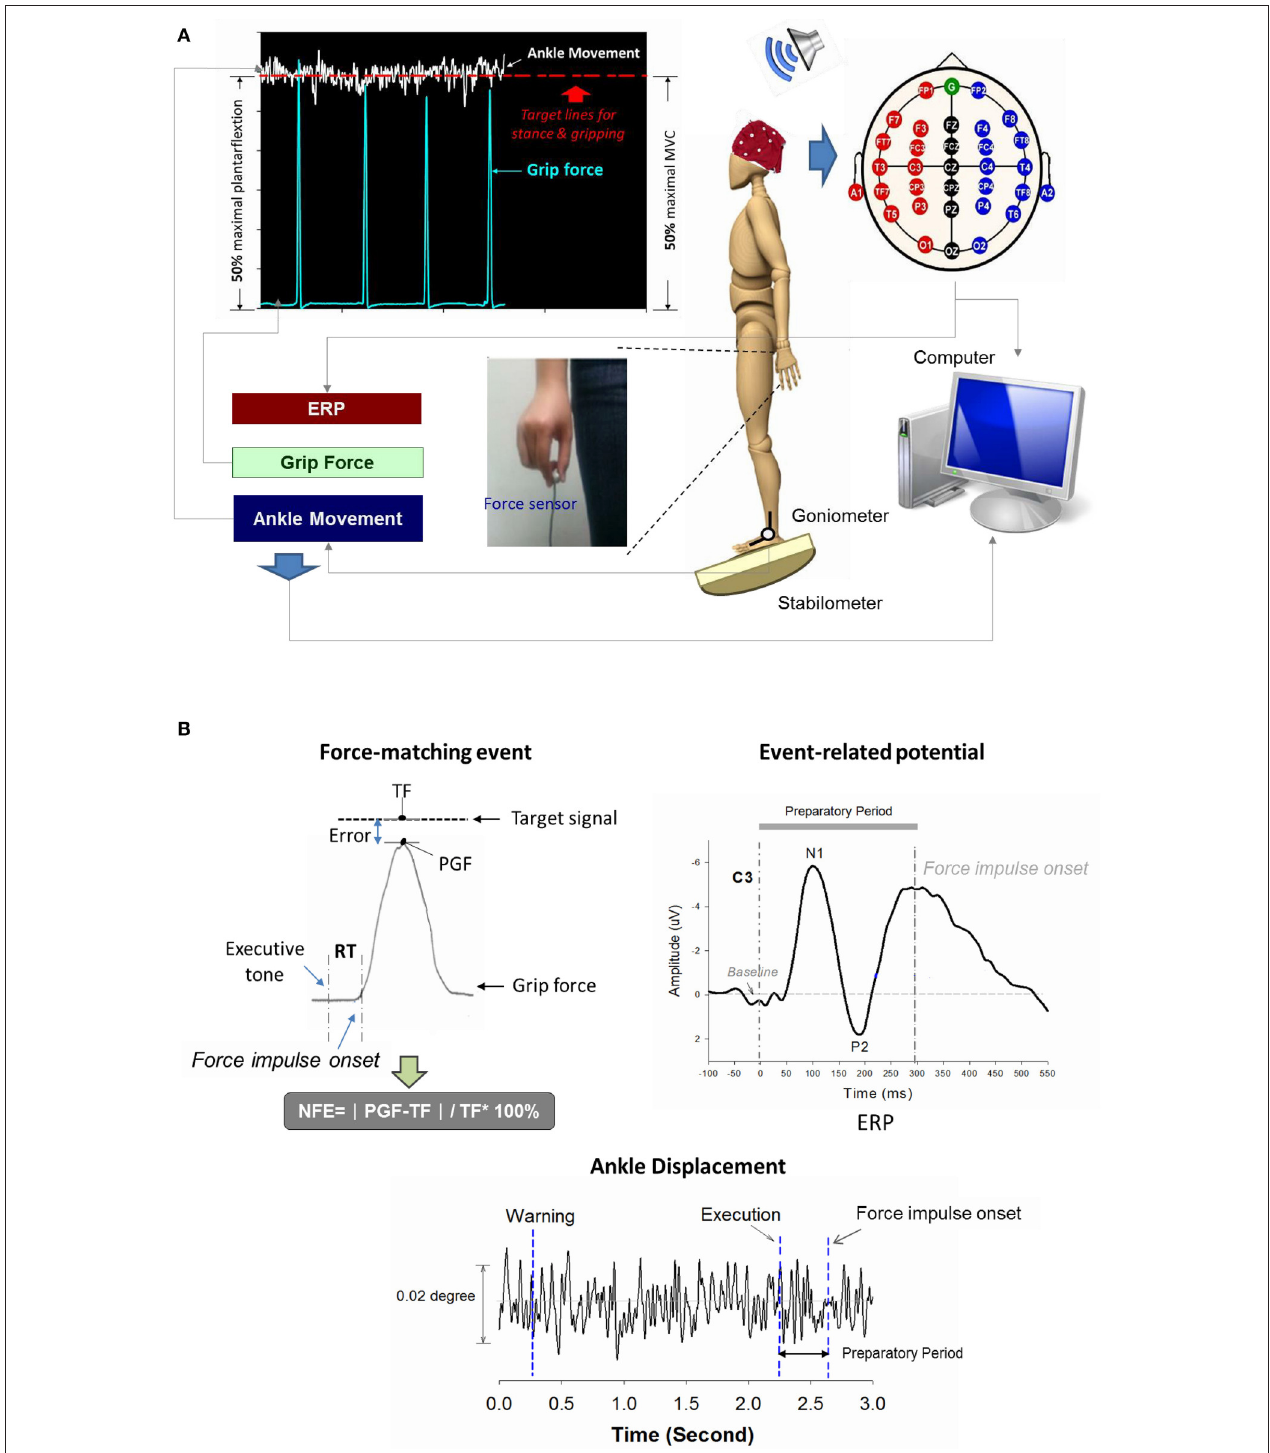
FIGURE 1 | Schematic illustration of experimental setup (A) and physiological data (B). Real-time display of precision grip force, ankle displacement, and target signals for concurrent force-matching and postural tasks. By separate scale-tuning of the manual force target and postural target, the target signals of both postural and force-matching tasks could be displayed in an identical position on the monitor. Suprapostural performance was assessed with the reaction time (RT) and normalized force error (NFE) of a force-matching act. The event-related potential (ERP) of the force-matching act was recorded with scalp electroencephalography. ERP between the executive tone and onset of the force-impulse profile was denoted as preparatory ERP, composed of N1 and P2 components. TF, target force; PGF, peak grip force.